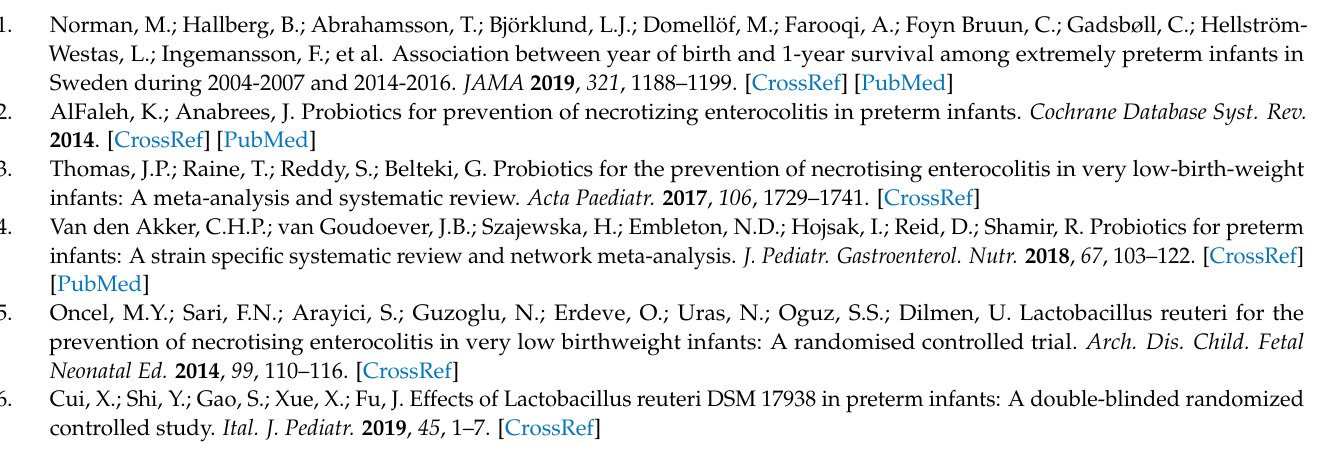
Table S3: Maternal and infant characteristics and L. reuteri abundance in the L. reuteri -supplemented group at one week of age, Table S4: Antibiotic treatment and L. reuteri prevalence in faeces of the L. reuteri -supplemented group, Table S5: Antibiotic treatment and L. reuteri abundance in faeces of the L. reuteri -supplemented group, Table S6: Maternal Lewis and secretor status and L. reuteri colonisation in the L. reuteri -supplemented group, Table S7: Human milk oligosaccharides and